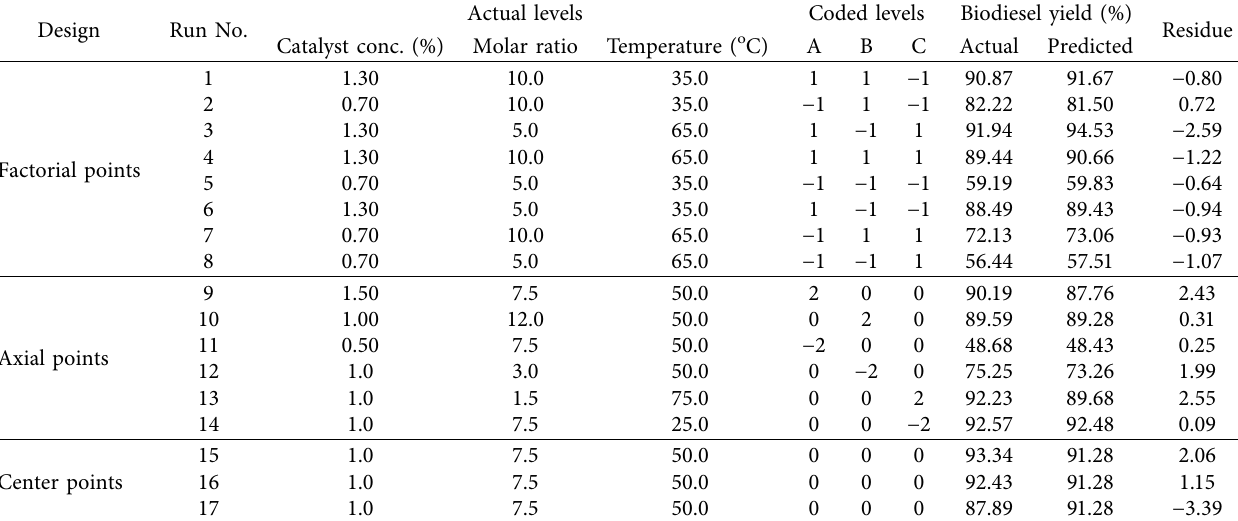
Table 4: CCD-based experimental design and results of mixed oil transesterification. Design